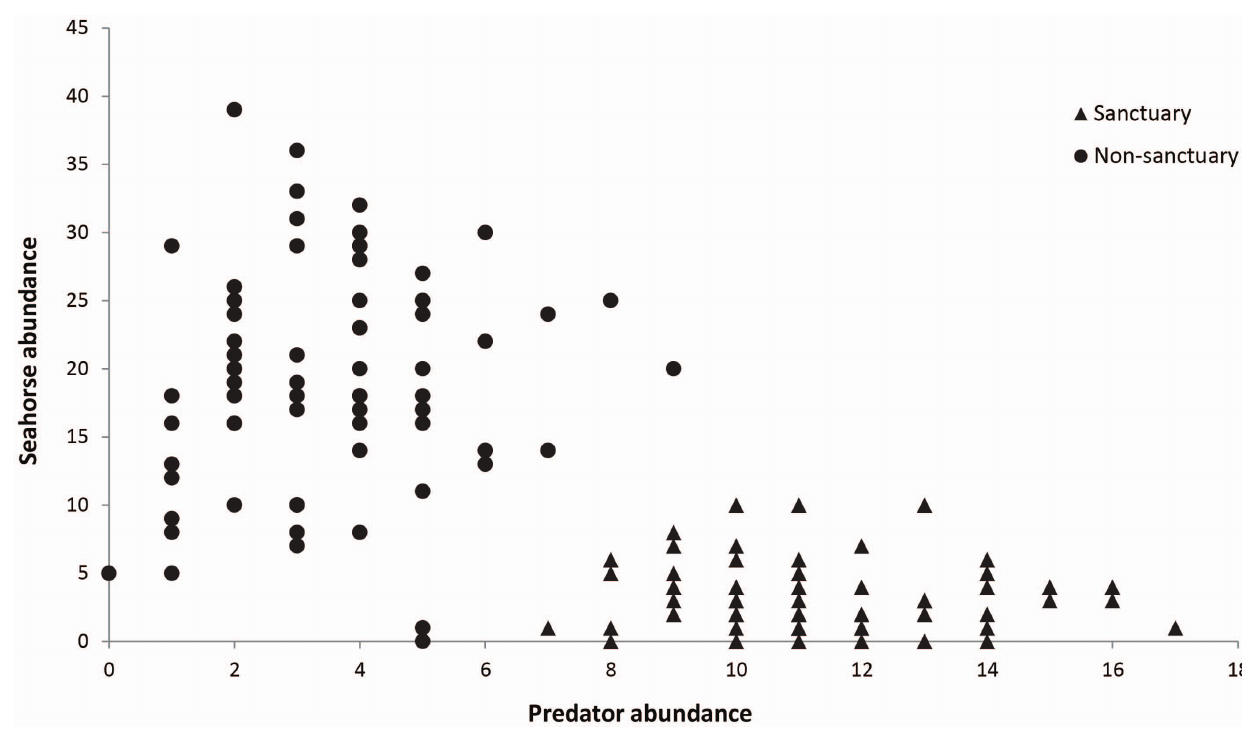
Figure 6. Relationship between monthly seahorse abundance and predator abundance from 2007–2009 at each site.